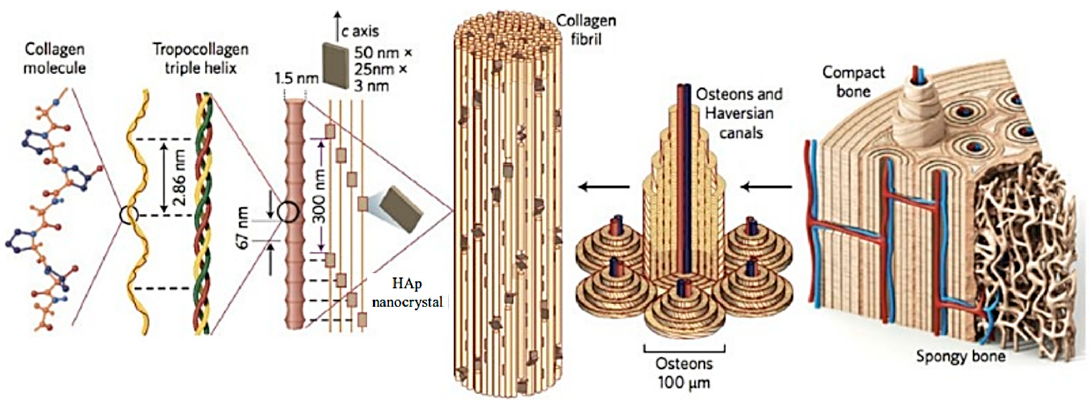
Figure 8. Scheme showing the hierarchical structure of bone with collagen and HAp as main components. Reproduced with permission from [55].